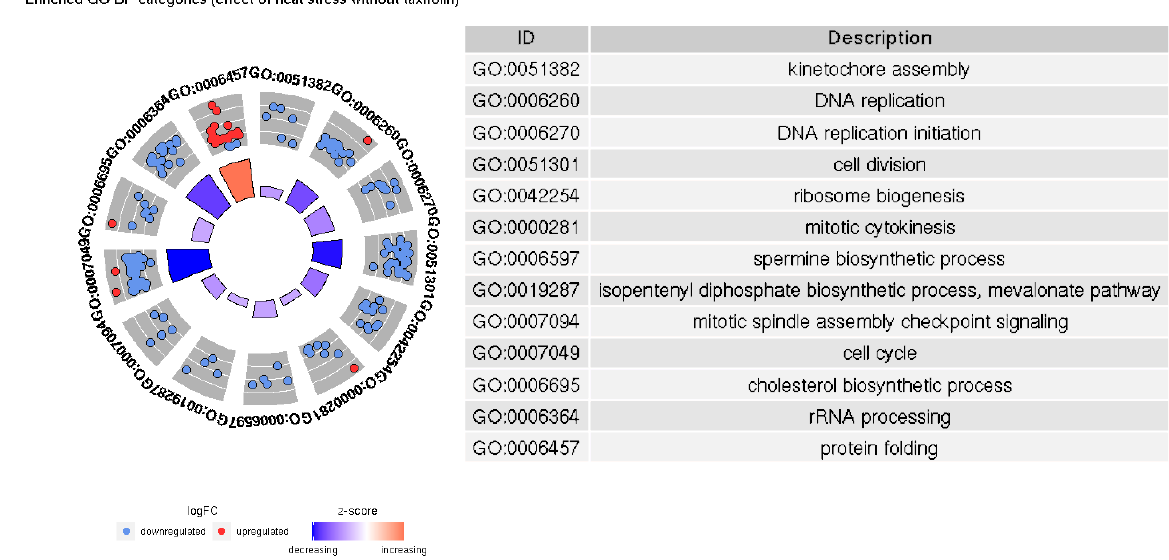
Figure 5. Significantly enriched GO BP categories in the HSnoTno/HSyesTno contrast.